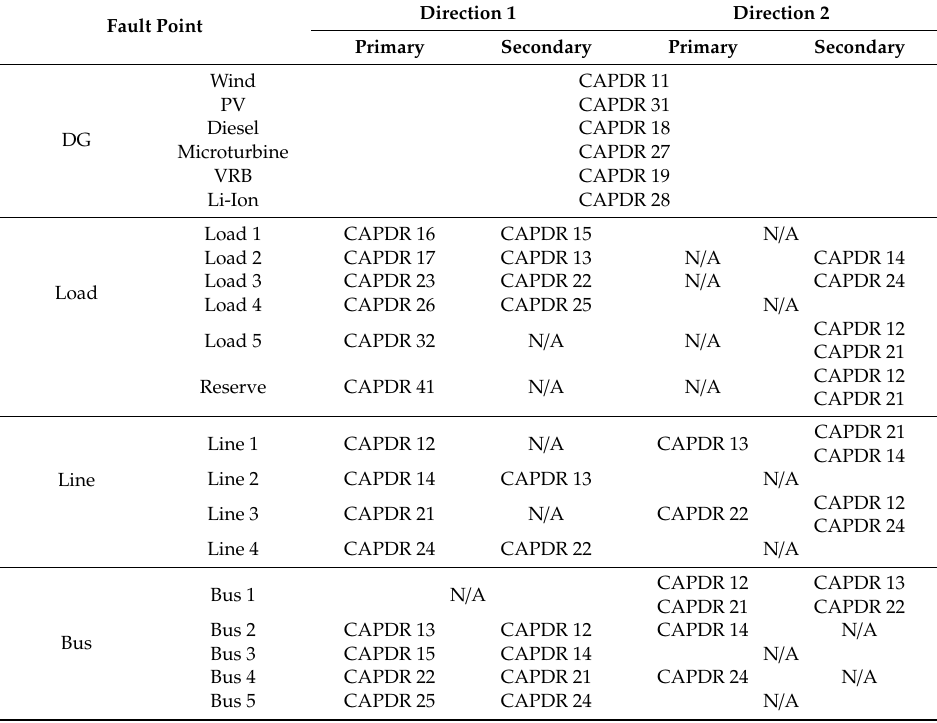
Figure 2. Model of the case study ADN with embedded CAPDRs. Table 1. Relays and their respective protection responsibility in the case study ADN.